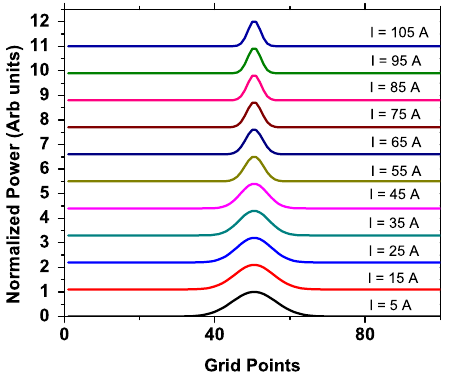
FIG. 2. For a closed cavity in the confocal configuration and a wavelength of 10 μ m, with an FEL interaction, cross section of the transverse mode as a function of electron current, obtained from the simulations.